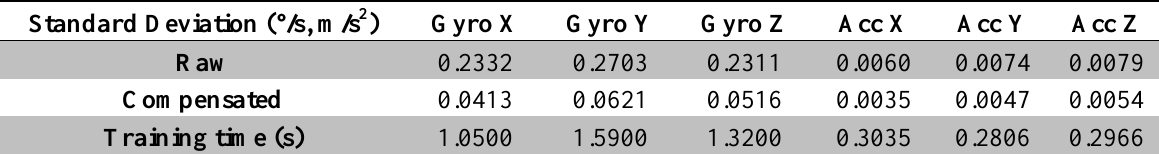
Table 5. Standard deviation of the raw and compensated datasets by RBFNN model along with the training